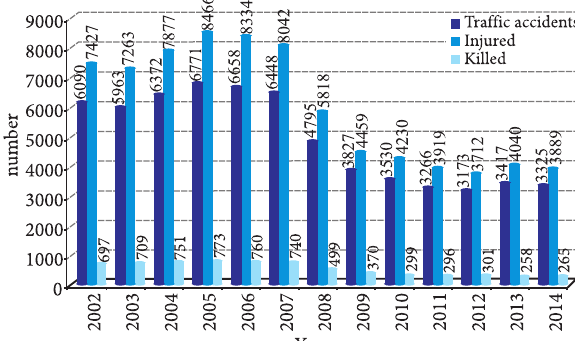
Fig. 4. The change in the number of road accidents in